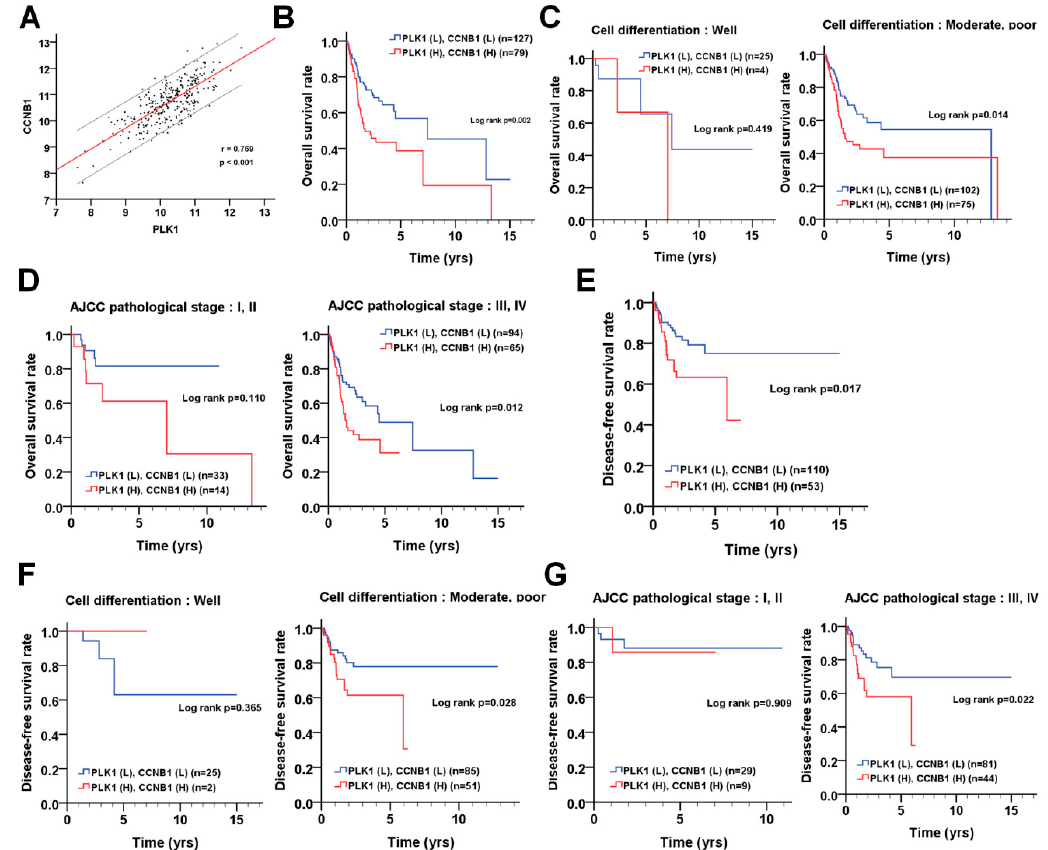
Figure 6. The association of PLK1 (polo-like kinase 1) and CCNB1 (cyclin B1) with overall survival and disease-free survival in OSCC (oral squamous cell carcinoma) patients. ( A ) The correlation between PLK1 and CCNB1 was estimated by Spearman’s rank correlation coe ffi cient. ( B ) The association of the coexpression levels of PLK1 and CCNB1 with overall survival in OSCC patients was analyzed with a Kaplan-Meier curve. The association of PLK1 and CCNB1 coexpression with overall survival was further stratified by ( C ) differentiation and ( D ) AJCC (American Joint Committee on Cancer) pathological stage. ( E ) The association of the coexpression levels of PLK1 and CCNB1 with disease-free survival in OSCC patients was analyzed with a Kaplan-Meier curve. The association of PLK1 and CCNB1 coexpression with disease-free survival was further stratified by ( F ) differentiation and ( G ) AJCC pathological stage. The cutoff values for the high or low expression of PLK1 in tumor tissues were based on the receiver operating characteristic (ROC) curve. The gene expression data and clinical information of OSCC are obtained from the TCGA dataset.